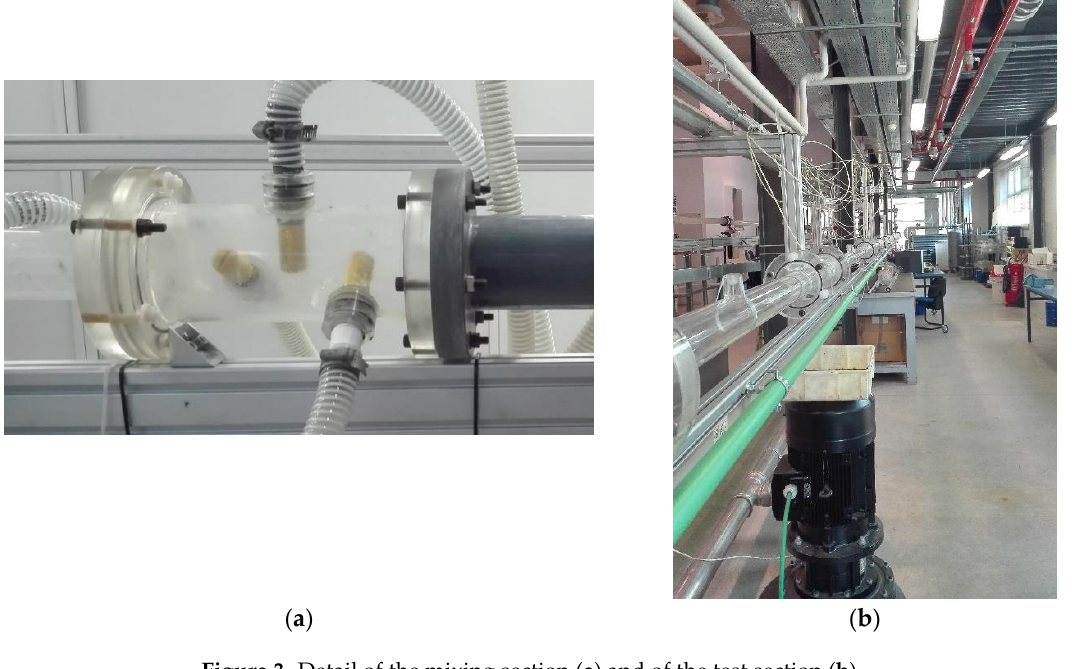
Figure 3. Detail of the mixing section ( a ) and of the test section ( b ). Table 1. Flow-meters